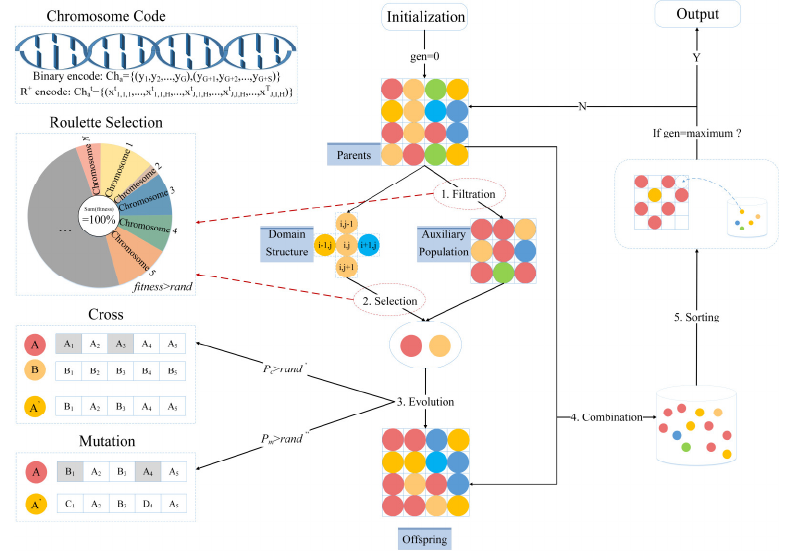
Figure 6. The procedure of MOCGA.